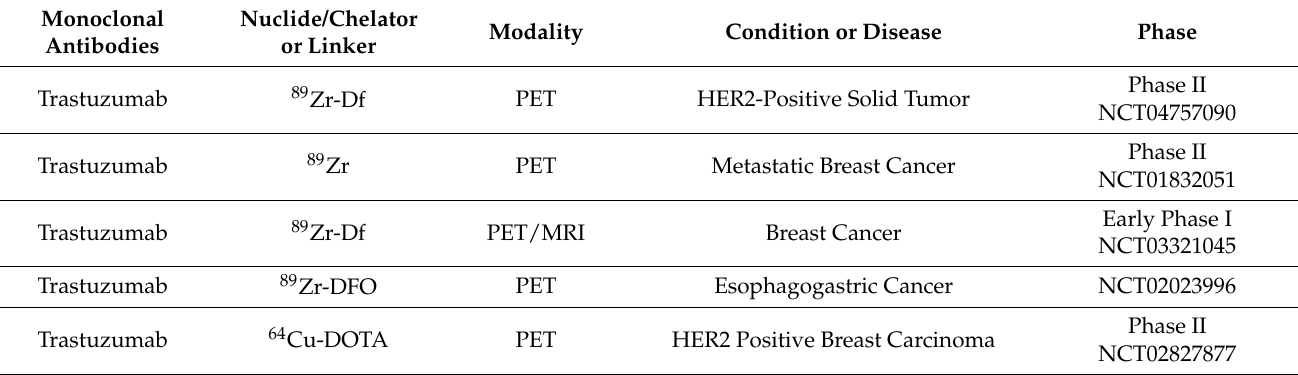
Table 2. The clinical trials of HER2-targeted monoclonal